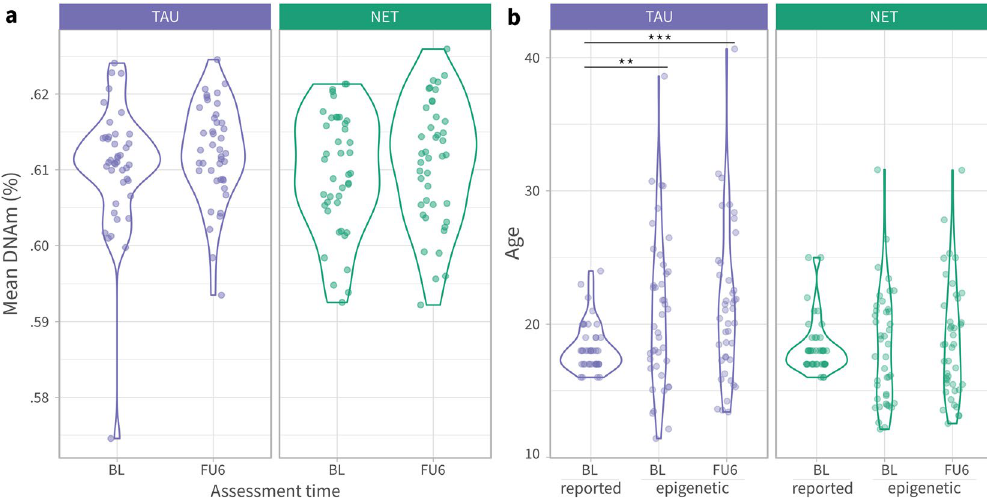
Figure 1. Violin plots showing individual observations of discovery sample. ( a ) Mean DNAm observed over all estimates (average Beta value) of probes used in EWAS. ( b ) Mean reported age and mean epigenetic ages. Points represent study participants. Colors represent treatment condition (TAU vs. NET). Assessment time refers to baseline (BL) and 6 month follow-up (FU6). Asterisks mark significant t-test comparisons (***p < 0.001; **p <